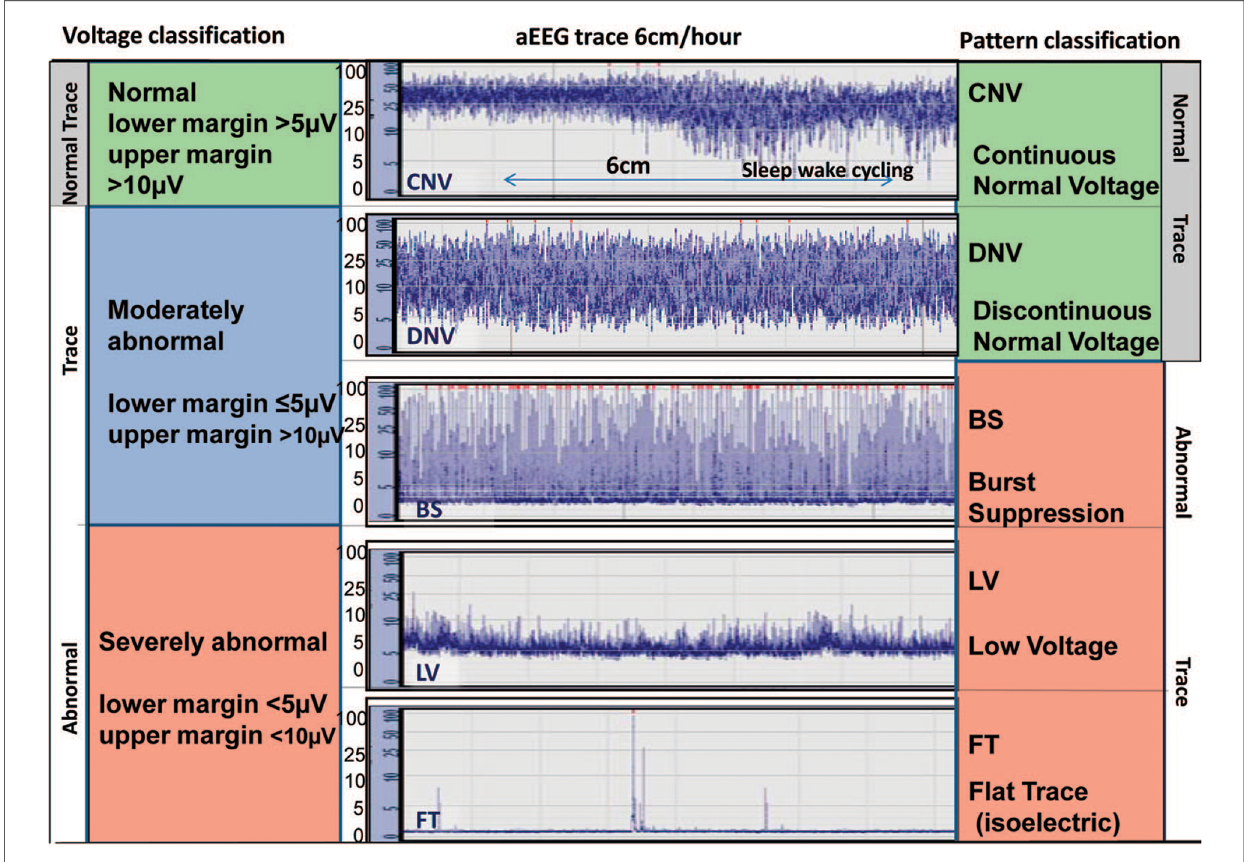
FIGURE 1 Classi fi cation systems for aEEG background pattern: Voltage method on left and pattern recognition on right (reproduced with permission from Hellstrom-Westas L. Continuous electroencephalography monitoring of the preterm infant. Clin Perinatol. 2006;33(3):633 – 47,